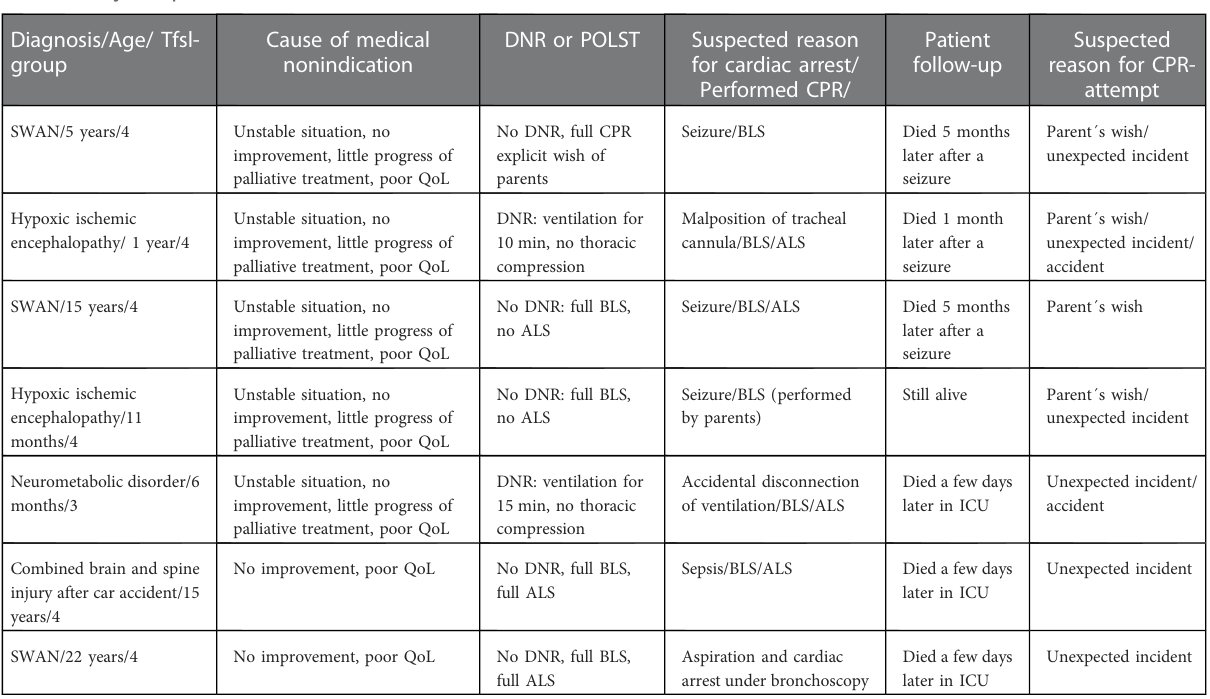
TABLE 2 Analysis of performed medical nonindicated CPR with